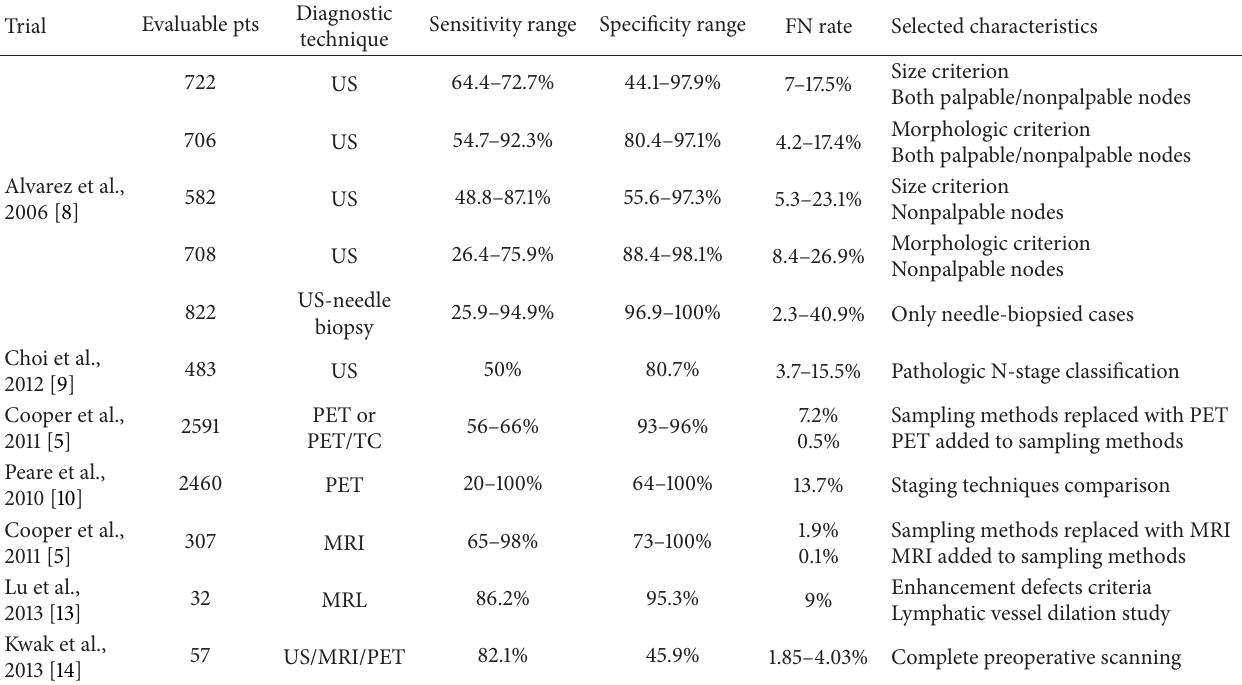
Table 1: Clinical results and accuracy of non-invasive diagnostic imaging techniques (US, PET-TC, and MRI) in breast cancer assessment of axillary node metastases of studies included in systematic